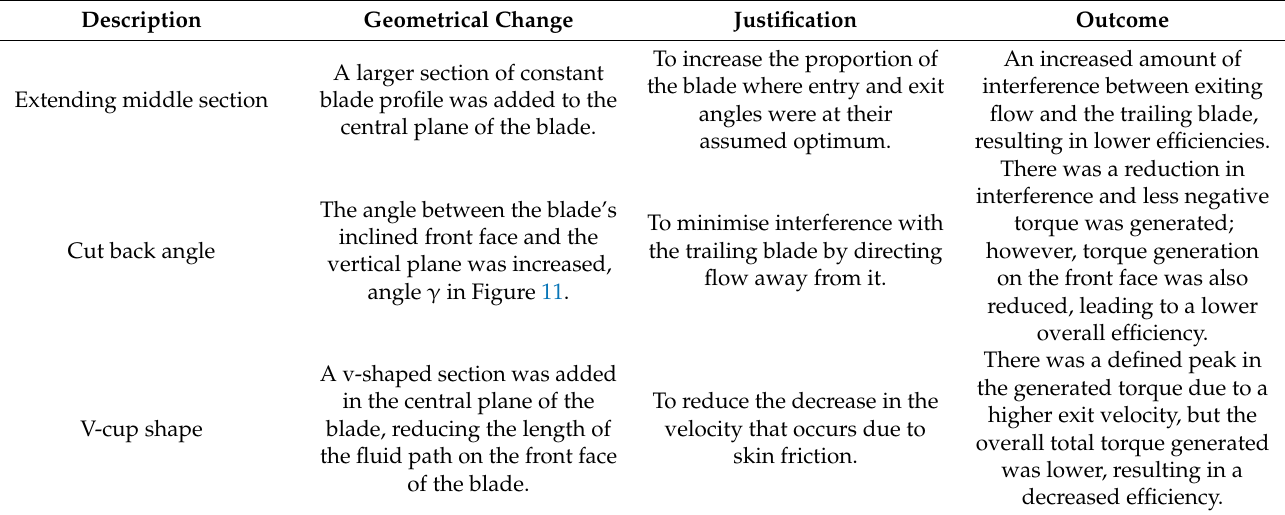
Table 4. Attempted design changes and their